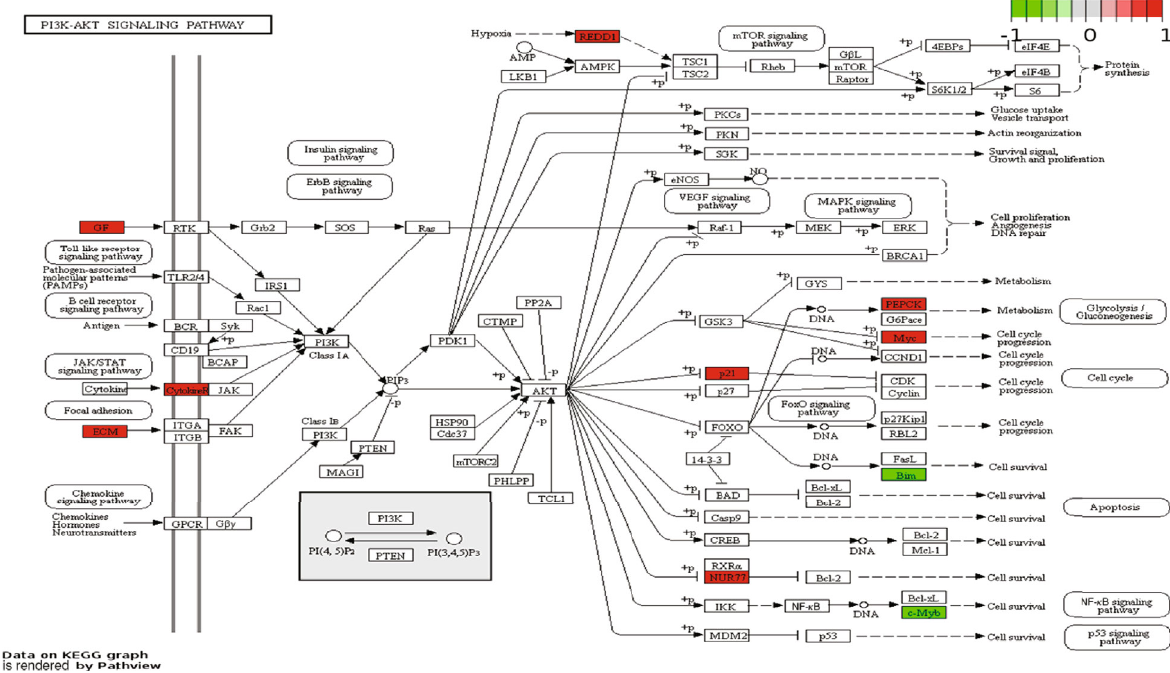
Figure 4: PI3K-AKT signaling pathway in Huh7 cells treated with FO. Expression changes of target genes are mapped by colors: red color marks increased genes; green color marks decreased genes.